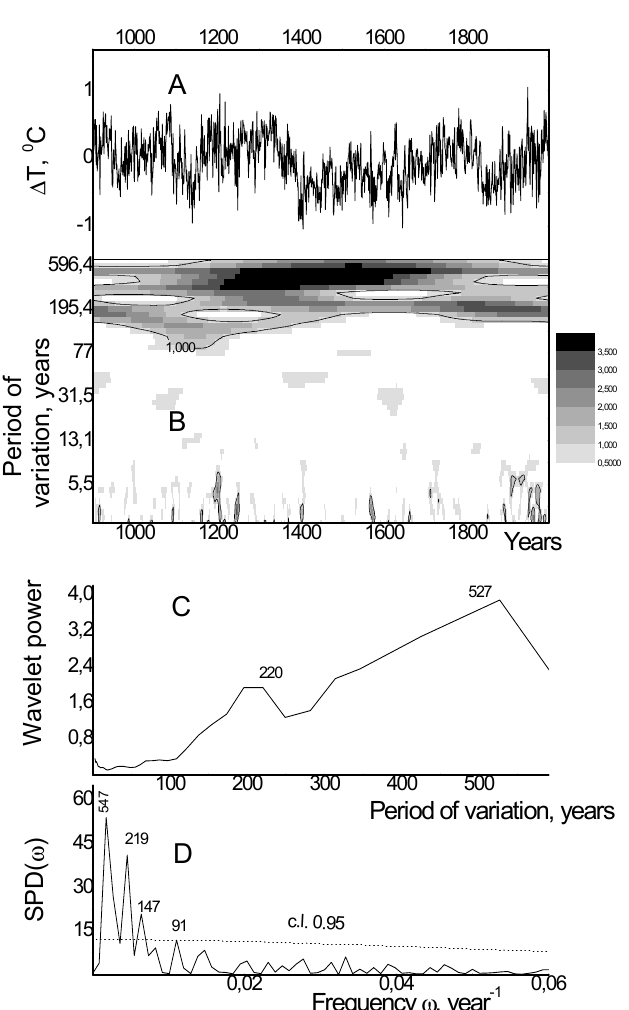
Figure 2. ( A )—Reconstruction of austral summer temperature in SSA [10]; ( B )—local Morlet wavelet spectrum of the time series [10]. The spectrum is normalized to 0.95 confidence level calculated for a red noise with AR(1) = 0.6. ( C )—global Morlet wavelet spectrum of the time series [10]; ( D )—Fourier spectrum of the time series [10]. Confidence level is based on continuum of spectrum of a red noise with AR(1) = 0.6. Cross-wavelet spectra show common features in the wavelet power of the temperature and solar time series, such as the peaks at 137, 216, and 520 years. Thus, cross-wavelet analysis also testifies in favor of the possible influence of solar activity on the climate of SSA. For further examination of a possible relationship between the solar-type temperature variations in SSA and activity of the Sun, correlation coefficients were calculated between time series wavelet filtered in the multi-centennial (393–548 years), Suess (186–282 years), and century-long (58–157 years) scale bands. It was found (see Figure 4) that SSA tem- perature shows some correlation with the solar activity proxies in multi-centennial scale band: R l (SSA, TSI) = 0.92 ( p = 0.945), R l (SSA, Φ ) = 0.89 ( p = 0.924). Confidence levels p were estimated using a statistical experiment (see [26]). No correlation was found between bicentennial and century-long variations in temperature and solar activity. The obtained results are illustrated in Figure